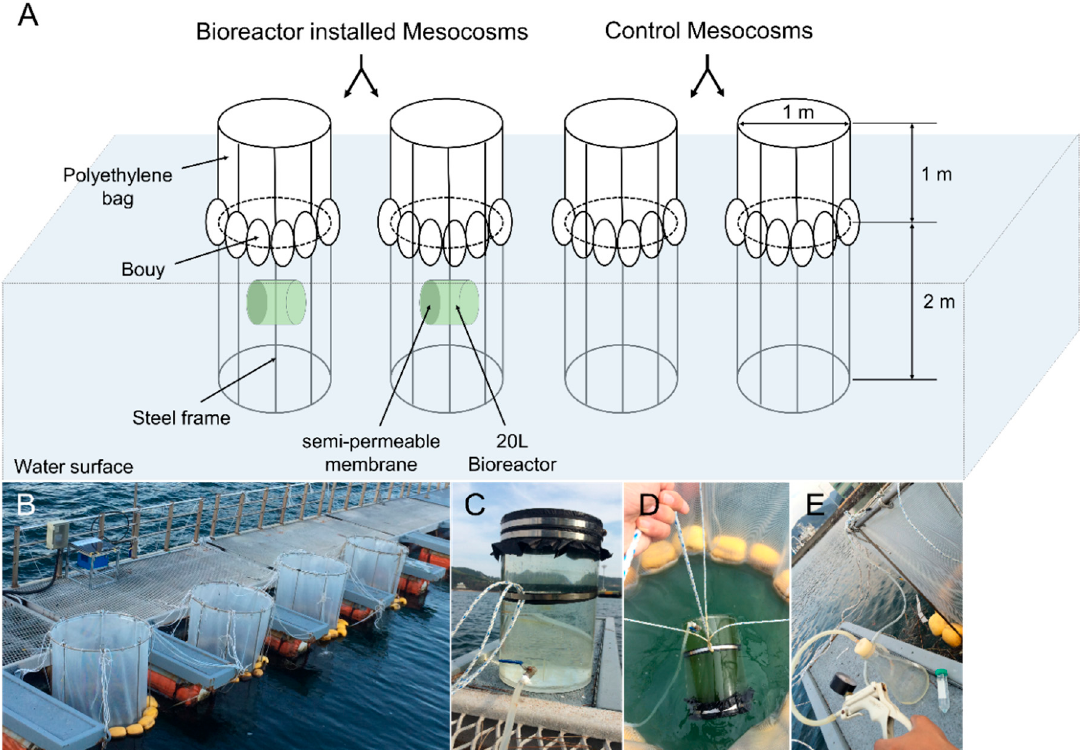
Figure 2. Schematic diagram designed four mesocosms for this study ( A ), and installed mesocosms at pier using ropes ( B ). Bioreactor (20 L) of Tetraselmis striata enclosed with semi-permeable membrane ( C ) and installed view in mesocosm using ropes ( D ). Sampling for T. striata cells using a suction flask through tubes which connected to the faucet of each bioreactor ( E ).